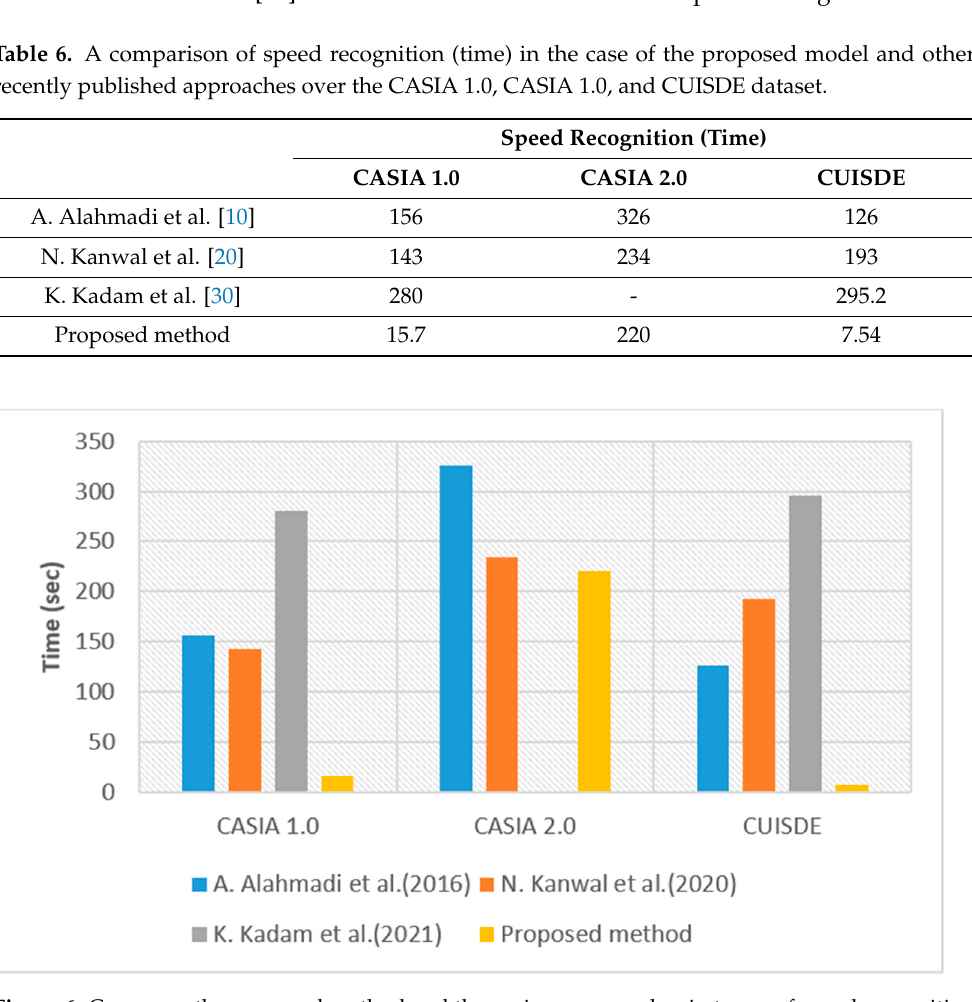
Figure 6. Compares the proposed method and the various approaches in terms of speed recognition (time) on the CASIA 1.0, CASIA 2.0, and CUISDE datasets [11,21,31]. The proposed model achieved high accuracy with a small number of parameters when compared to recently published approaches, as shown in Table